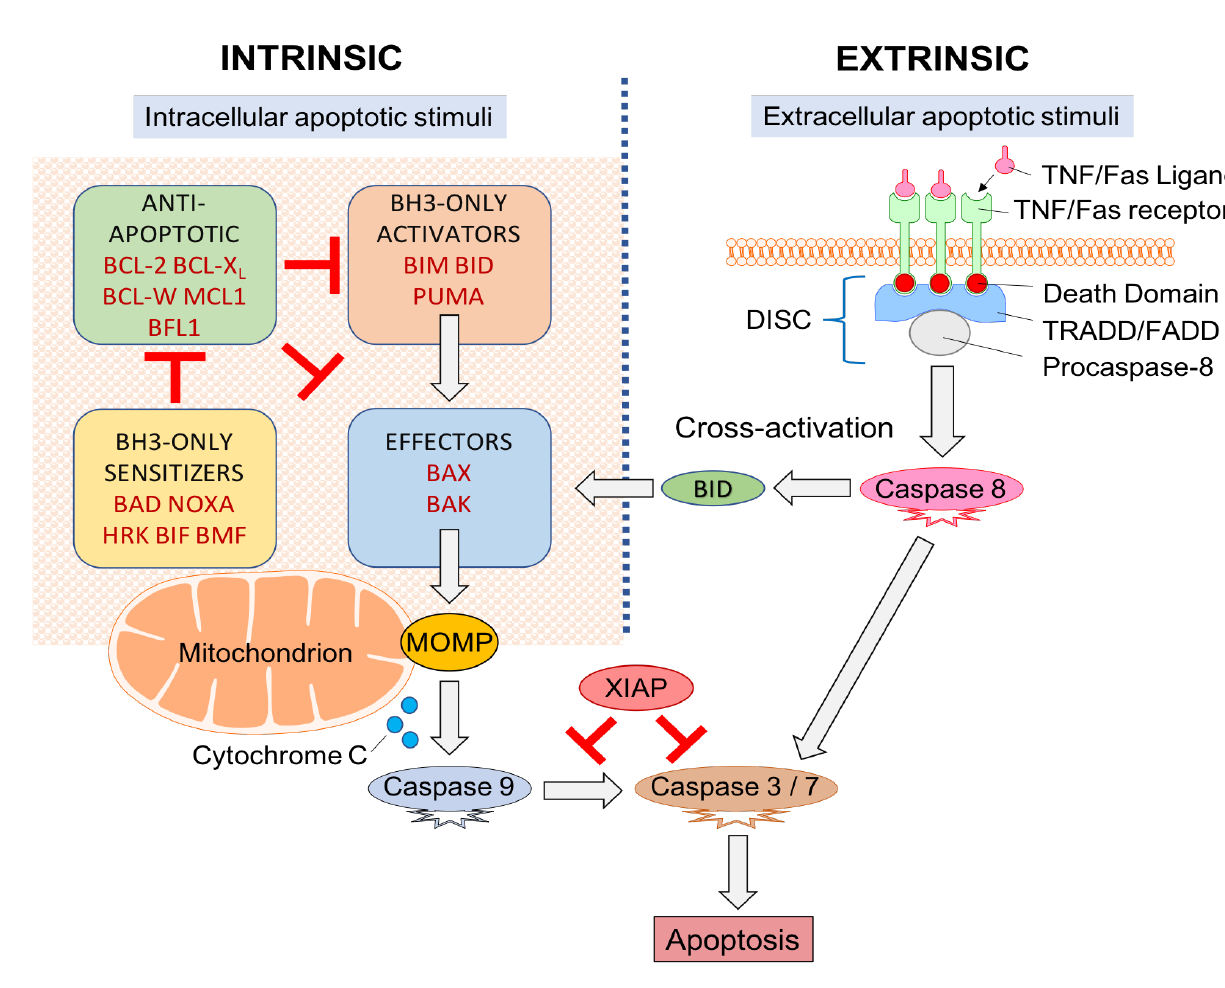
Figure 1. Apoptotic signaling pathway. “Extrinsic” and “intrinsic” pathways both activate caspases. Cross-activation between pathways is made possible through BID (a BCL-2 family member protein). BCL-2 proteins act within the mitochondrion with the relative expression of pro- and anti-apoptotic proteins determining if the apoptotic threshold is crossed and MOMP can proceed.